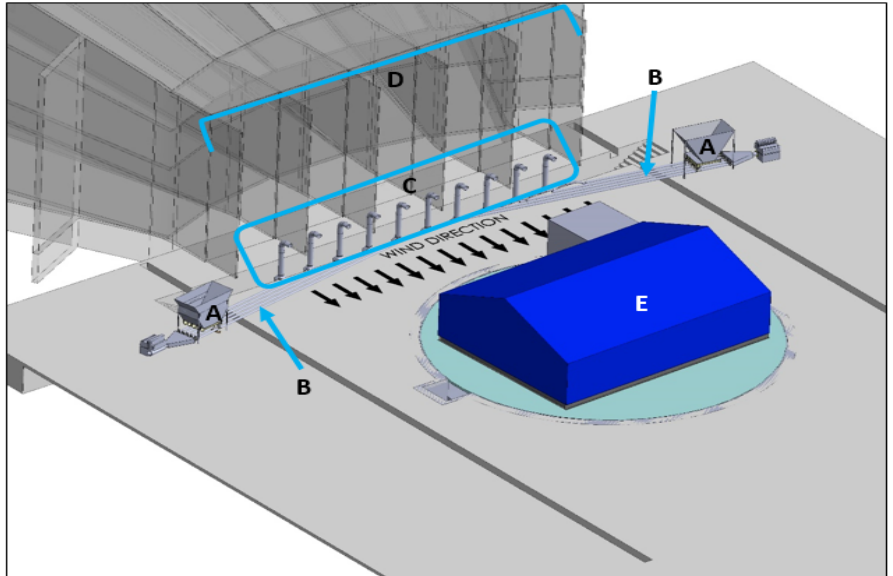
Figure 5. Auger feed and ember generation system, including left and right hoppers ( A ); auger feed lines ( B ) for delivery of fuel to generators ( C ); fan array ( D ); and test building ( E ).